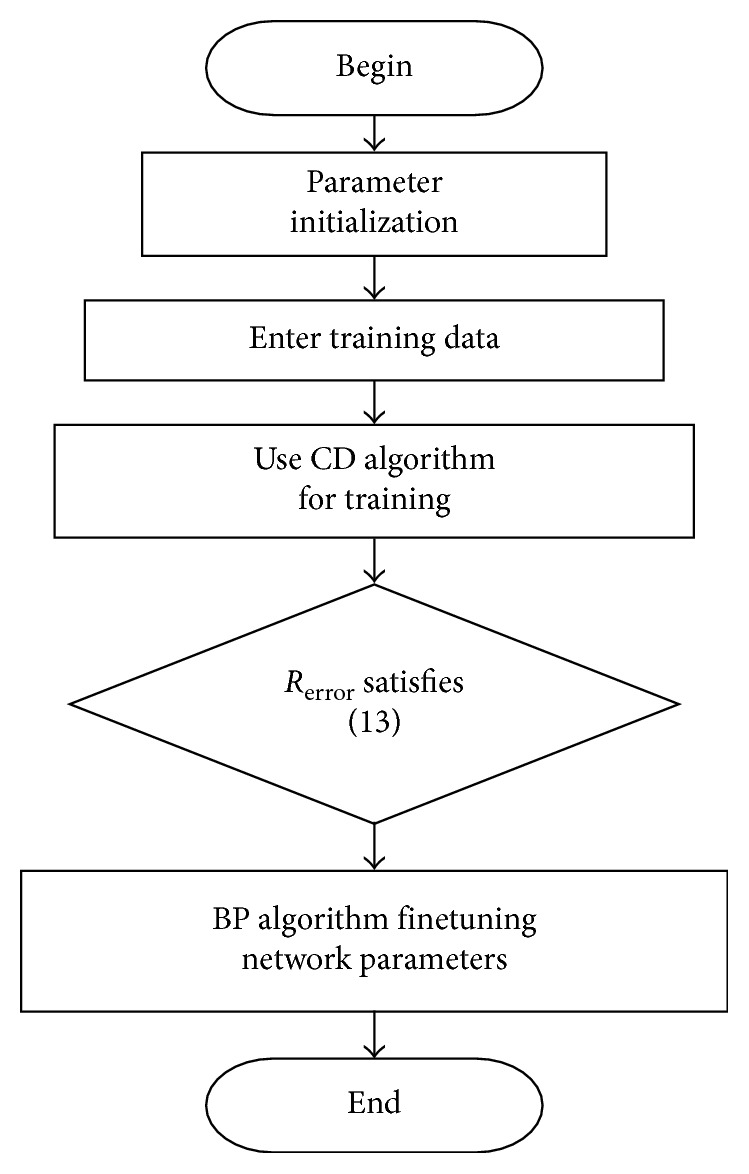
Calculation flowchart of DBNs depth.